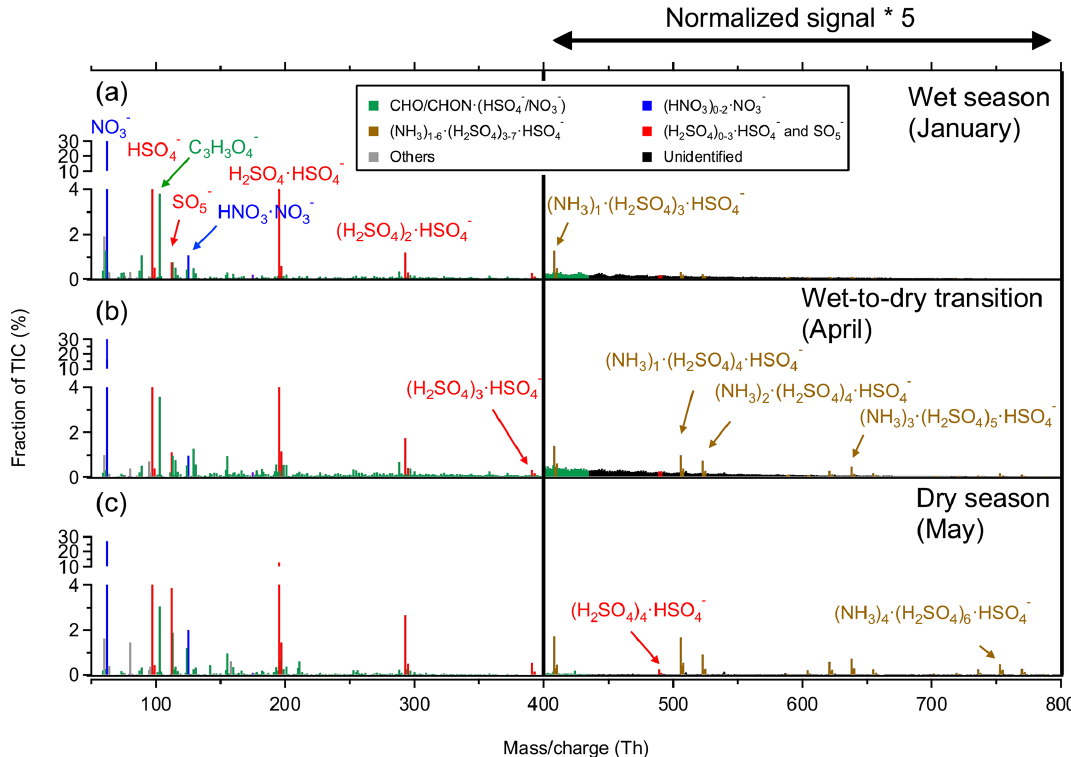
Figure 5. Mass spectra of negative ions at CHC averaged between 07:00 and 19:00 in (a) the wet season (January), (b) the wet-to-dry transition period (April), and (c) the dry season (May). The normalized signal intensities from 400 to 800Th are multiplied by a factor of 5 for better visualization.